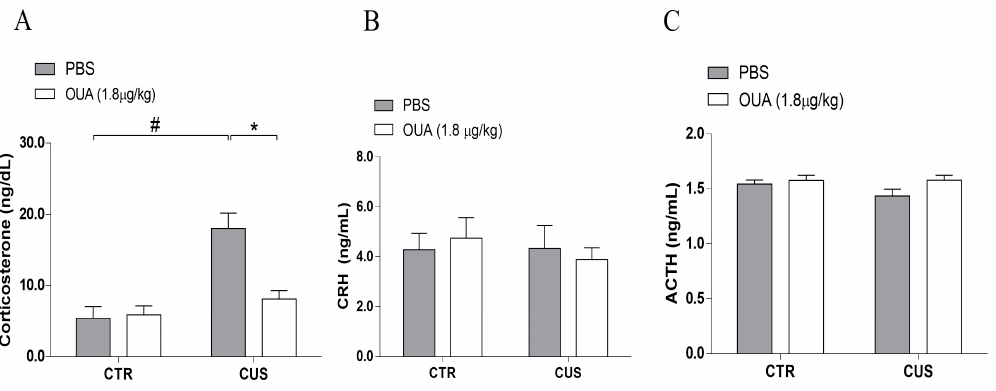
Figure 2. Ouabain reduces serum corticosterone levels in animals submitted to CUS. ( A ) Animals submitted to the CUS display an increase in serum corticosterone levels (ng/dL) (F (1, 24) = 0.58; p = 0.0001 for CUS factor), # p < 0.001 when compared to CTR x CUS; and * p < 0.001 when compared to CTR-CUS x CUS+OUA, 24 h after the last stressor stimulus, in relation to the CTR group ( n = 7), and chronic treatment with OUA reduces corticosterone concentration in relation to the CUS group (F (1, 24) =8.108; p = 0.0089 for treatment factor). ( B ) CRH (ng/mL) ( n = 13–15) (F (1, 51) = 3.117; p = 0.0835 for CUS factor. F (1, 51) =0.09387; p = 0.7606 for treatment factor). ( C ) ACTH